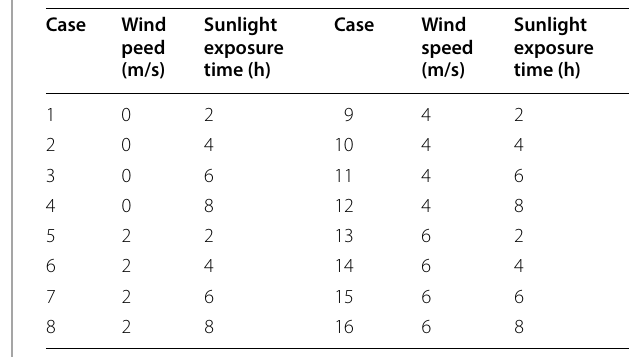
Table 2 Concrete curing conditions (Kim et al.